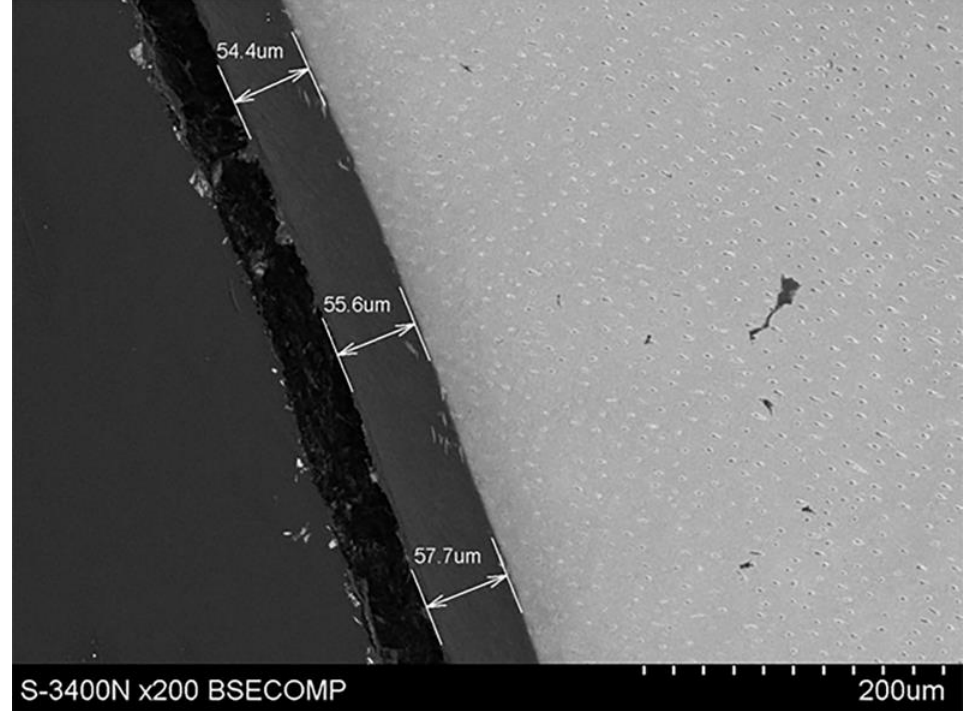
Figure 5. Scanning electron microscope image showing the thickness of root cement below the cer- vical region, in the apical direction.